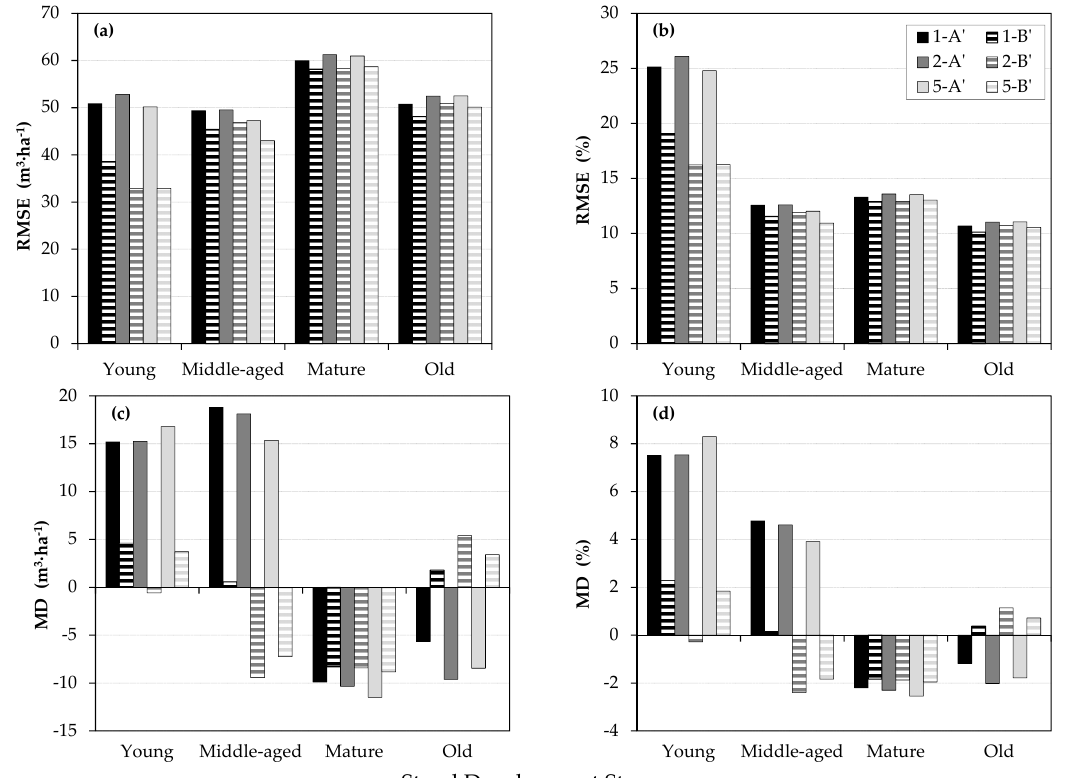
Figure A3. Validation results by stand development stages (young, middle-aged, mature, and old) for six selected double-log volume models (validation dataset) described in Table A3: ( a ) root mean square error (RMSE); ( b ) relative root mean square error (RMSE % ); ( c ) mean difference (MD); and ( d ) relative mean difference (MD % ).